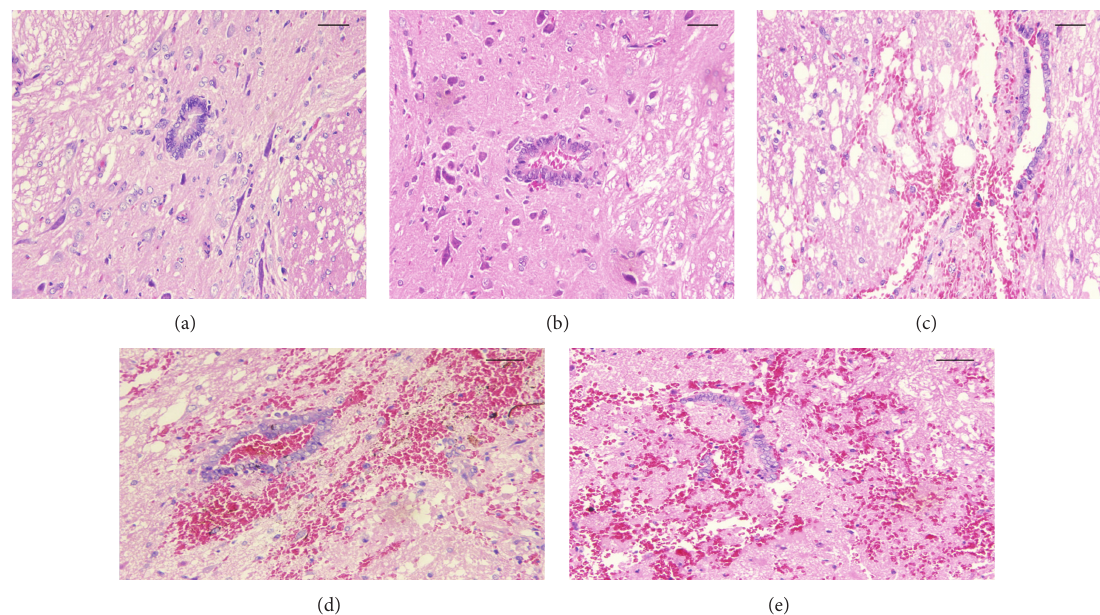
Figure 1: The severity of SCI was evaluated using hematoxylin-eosin staining (original magnification × 400). The spinal cord tissues were normal in the sham-operated group (a). The spinal cord demonstrated obvious sign of compression following SCI and the organization structure was destroyed as observed in (b). Next, the degree of inflammation gradually increased. A few scattered small foci of hemorrhage from small veins and capillaries and nerve cells are swollen and necrosis was observed at 24 h (c). The severity of the nerve cell necrosis and interstitial inflammatory cell infiltration were markedly increased at 48 h (d). Extensive hemorrhage and nerve cell necrosis was observed in at 72 h (e). Bar equals 50 𝜇